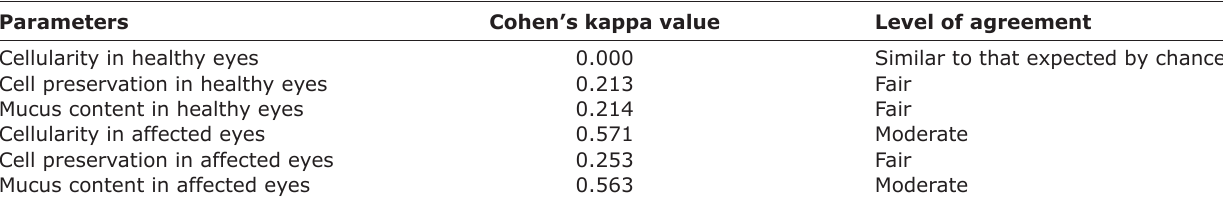
Table-2: Agreement between two variably experienced evaluators regarding the quality parameters of the cytology samples. Parameters Cellularity in healthy